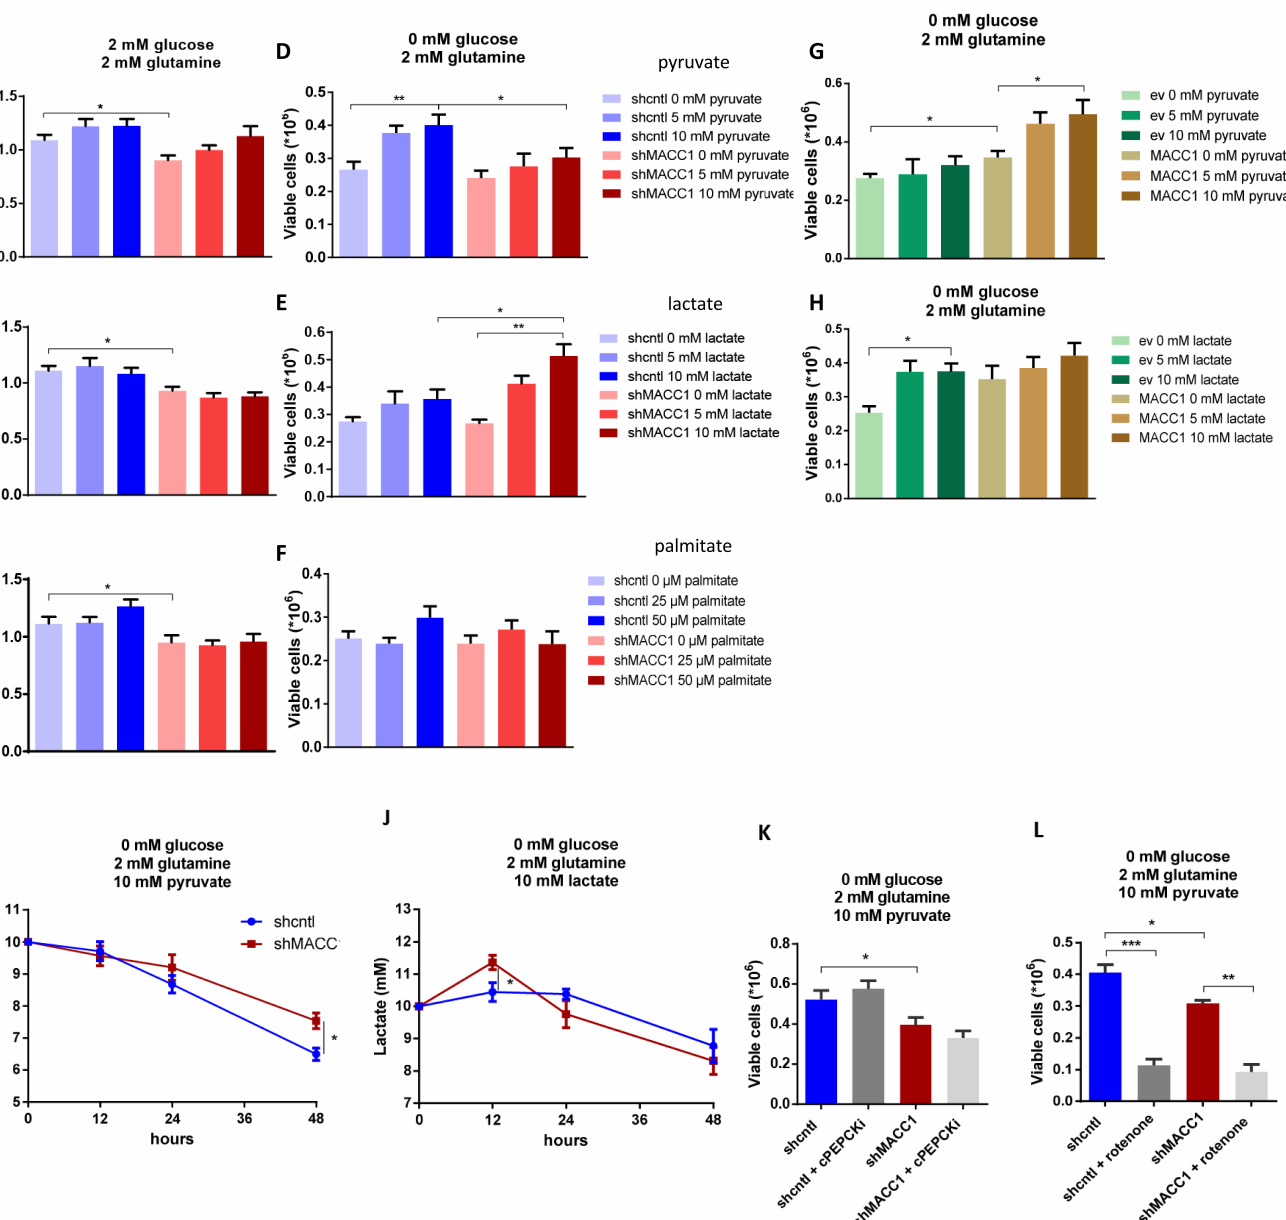
Figure 5. MACC1 promotes pyruvate and restricts lactate use in glucose-depleted environment. ( A – F ) Cell viability of pyruvate treated SW620 shcntl and shMACC1 cells, lactate and palmitate at indicated concentrations in ( A – C ) low glucose and ( D – F ) glucose-depleted conditions. ( G – H ) Cell viability of SW480 ev and MACC1 overexpressing cells treated as indicated in glucose-depleted conditions. ( I ) Pyruvate and ( J ) lactate depletion from cell growth medium of SW620 shcntl and shMACC1 cells after 48 h cultivation under indicated conditions. Cell viability of SW620 shcntl and SW620 shMACC1 cells treated at indicated conditions with ( K ) cytoplasmic phosphoenolpyruvate carboxykinase (PEPCK) inhibitor (cPEPCKi) and ( L ) mitochondrial complex I inhibitor rotenone. * p ≤ 0.05, ** p ≤ 0.01, *** p ≤ 0.001. Data represent mean values ± SEM of at least three independent